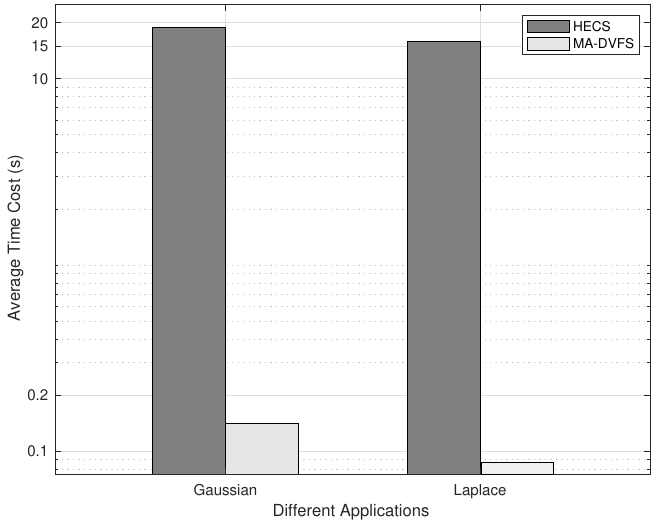
Figure 9. Average time cost for each generation.